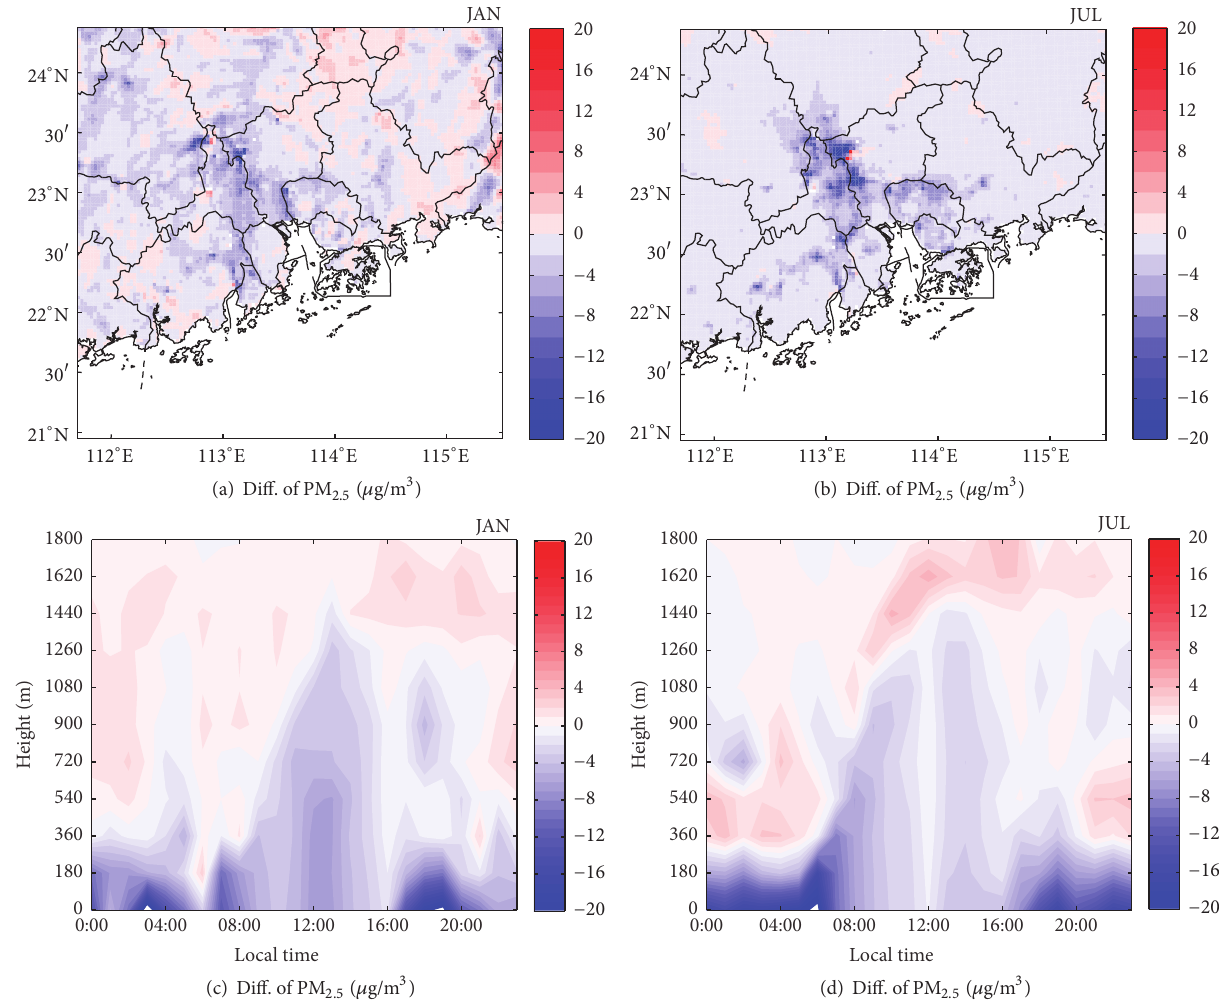
Figure 9: Spatial distribution of monthly-average PM 2.5 concentration differences ( 𝜇 g/m 3 ) (a, b) and vertical distribution of PM 2.5 differences ( 𝜇 g/m 3 ) (c, d) at GZ between the GLC2009 case and the GLC2000 case (differences = GLC2009 −